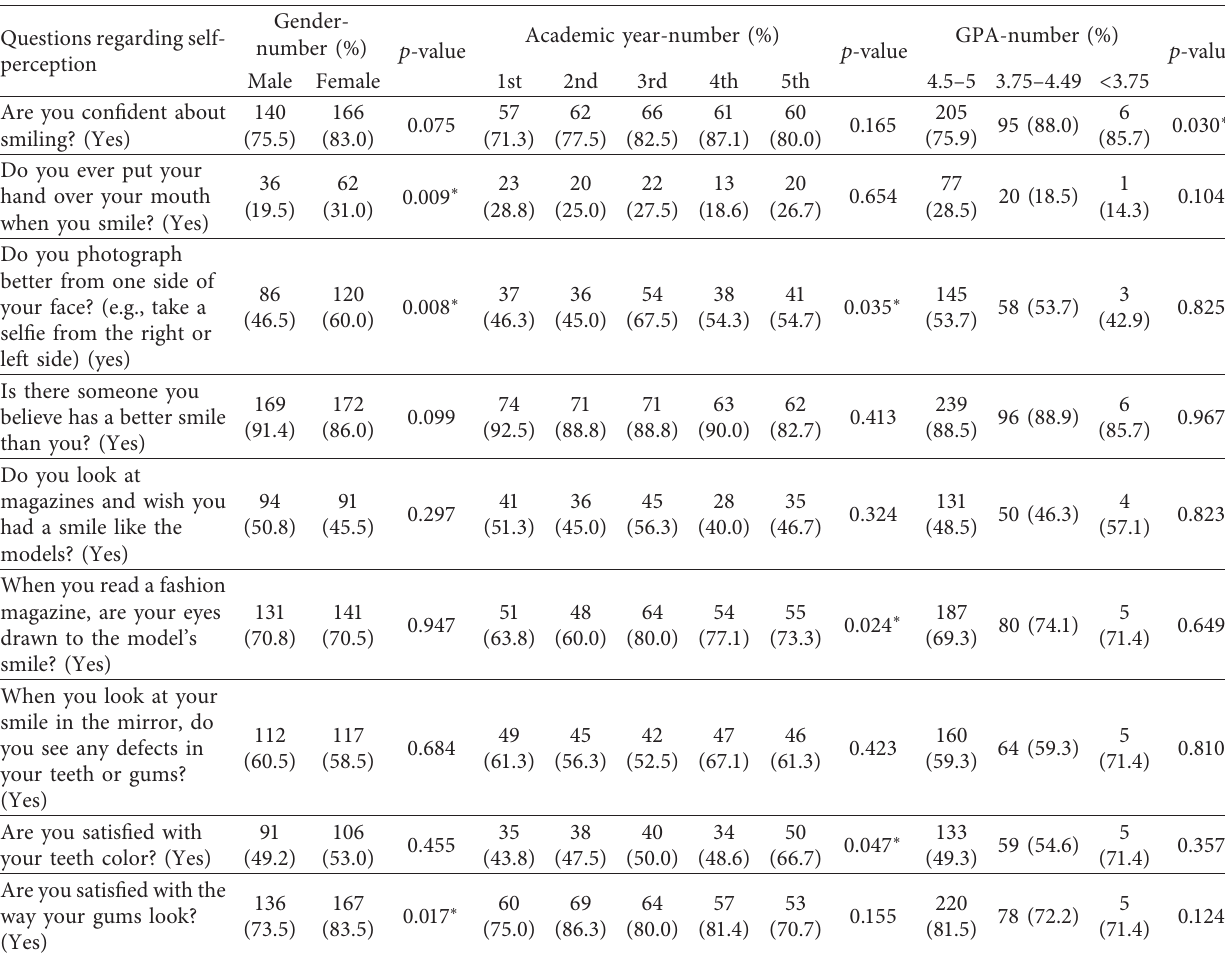
Table 3: Comparison of the subjects’ responses toward desired esthetic treatments with respect to their gender, academic year, and GPA (part